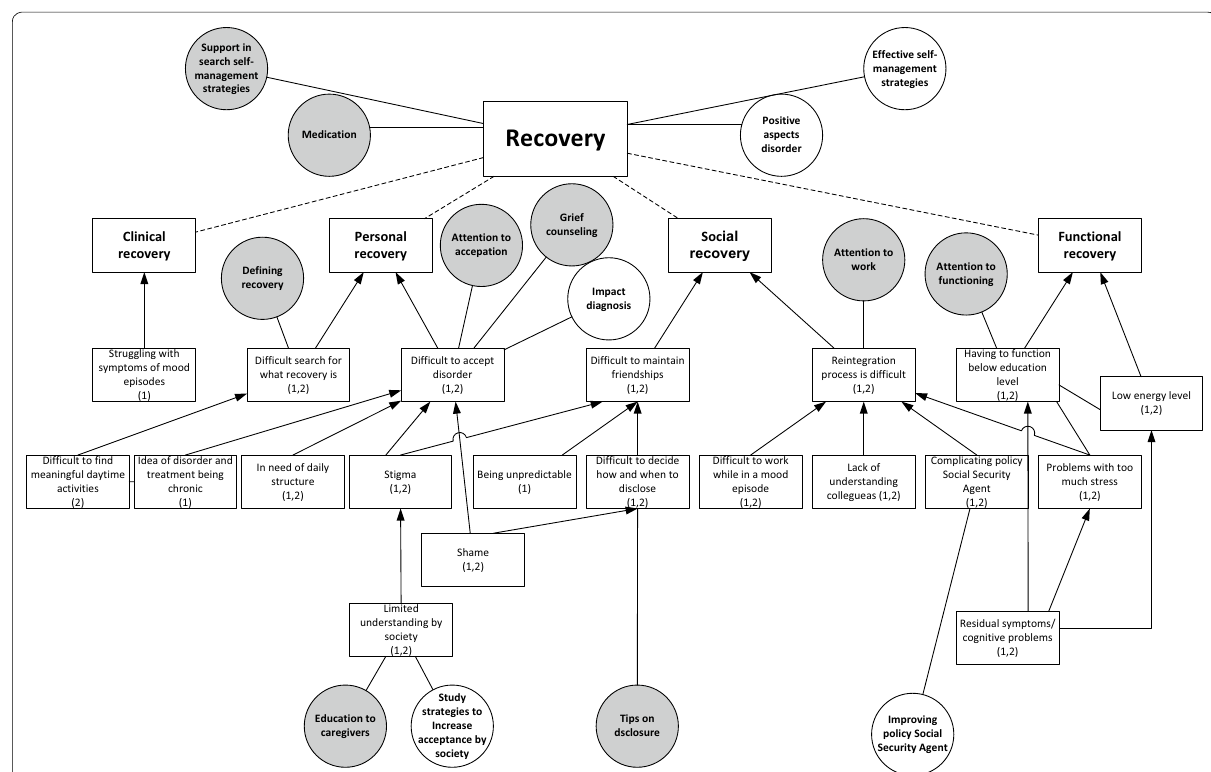
Fig. 3 Challenges with recovery (squares) including relating research needs (white circles) and care needs (grey circles). (1): mentioned in study on research needs; (2): mentioned in study on care needs. Dotted lines: division of challenges into sub challenges. Arrows: causal relation between challenges